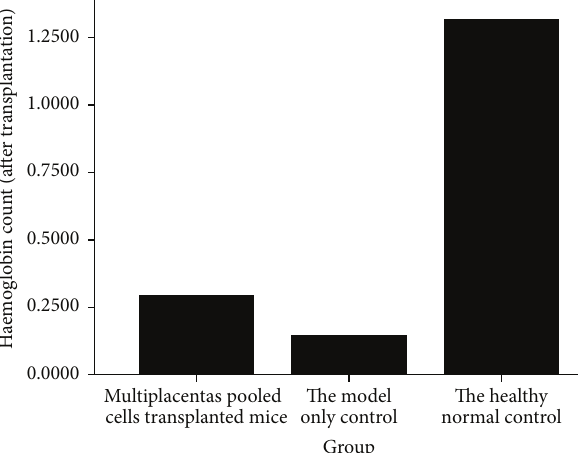
Figure 1: Mice peripheral blood hemoglobin count at day seven after placentas pooled cell treatment.